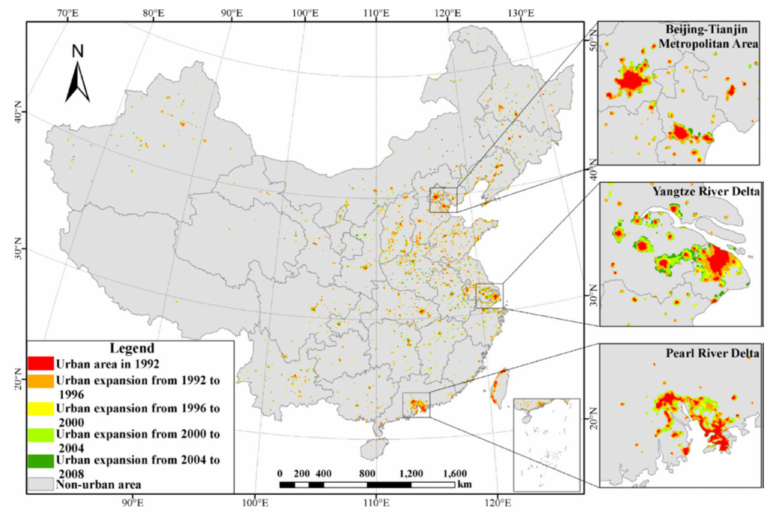
Figure 16. The dynamics of urban expansion in China from 1992 to 2008. Source: